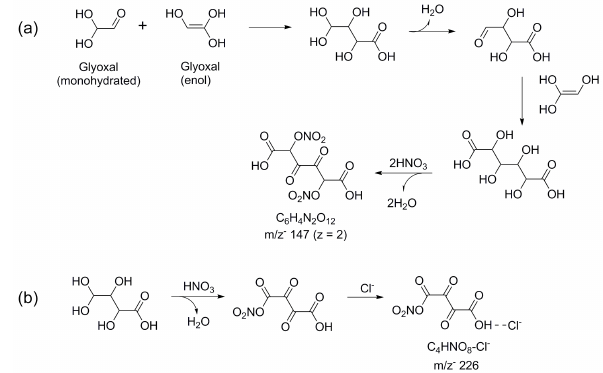
Scheme 4. Proposed formation of two organonitrates, m / z − 147 (a) and m / z − 226 (b)